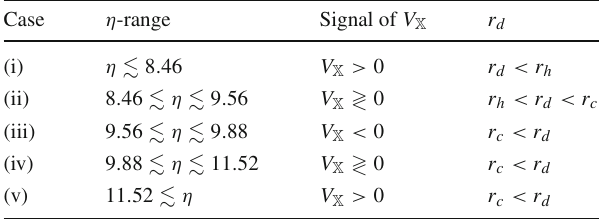
Table 2 Different regions for the potential in RNdS, with M = 5 Q / 3 = ( L / 5 . 4 ) 2 = (cid:2)/ 2 = 1